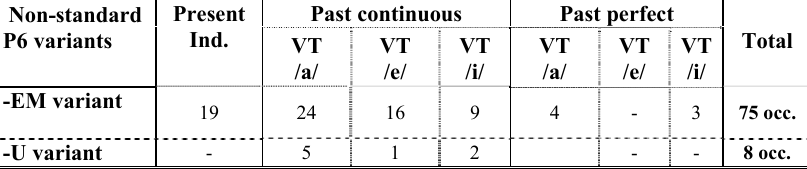
Table VI: Diffusion of non-standard P6 variants in different verbal paradigms (Funchal) Past continuous Past perfect